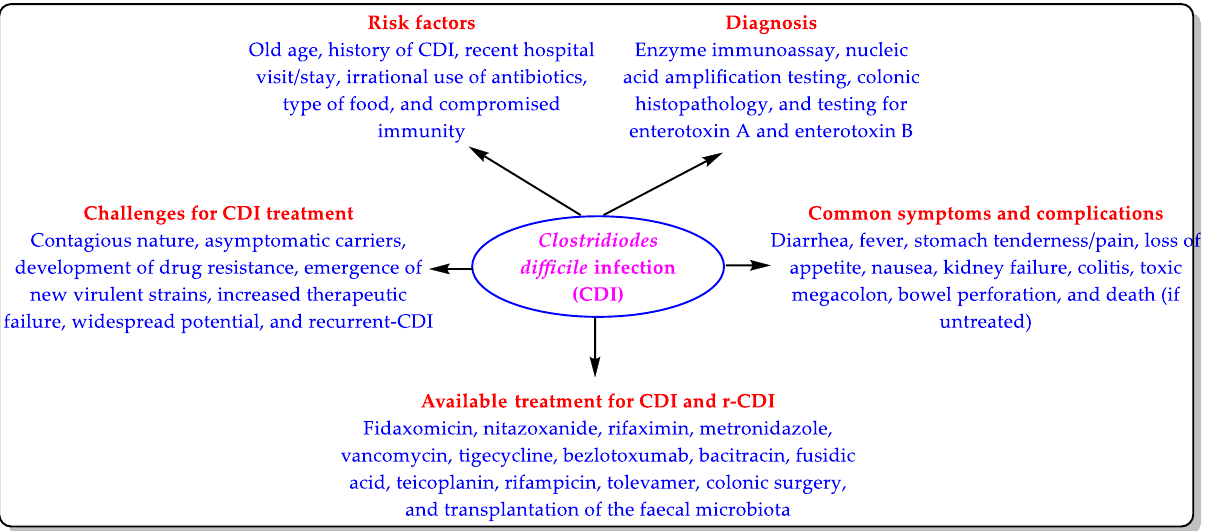
Figure 1. Risk factors, symptoms, diagnosis, treatment, and challenges of CDI.